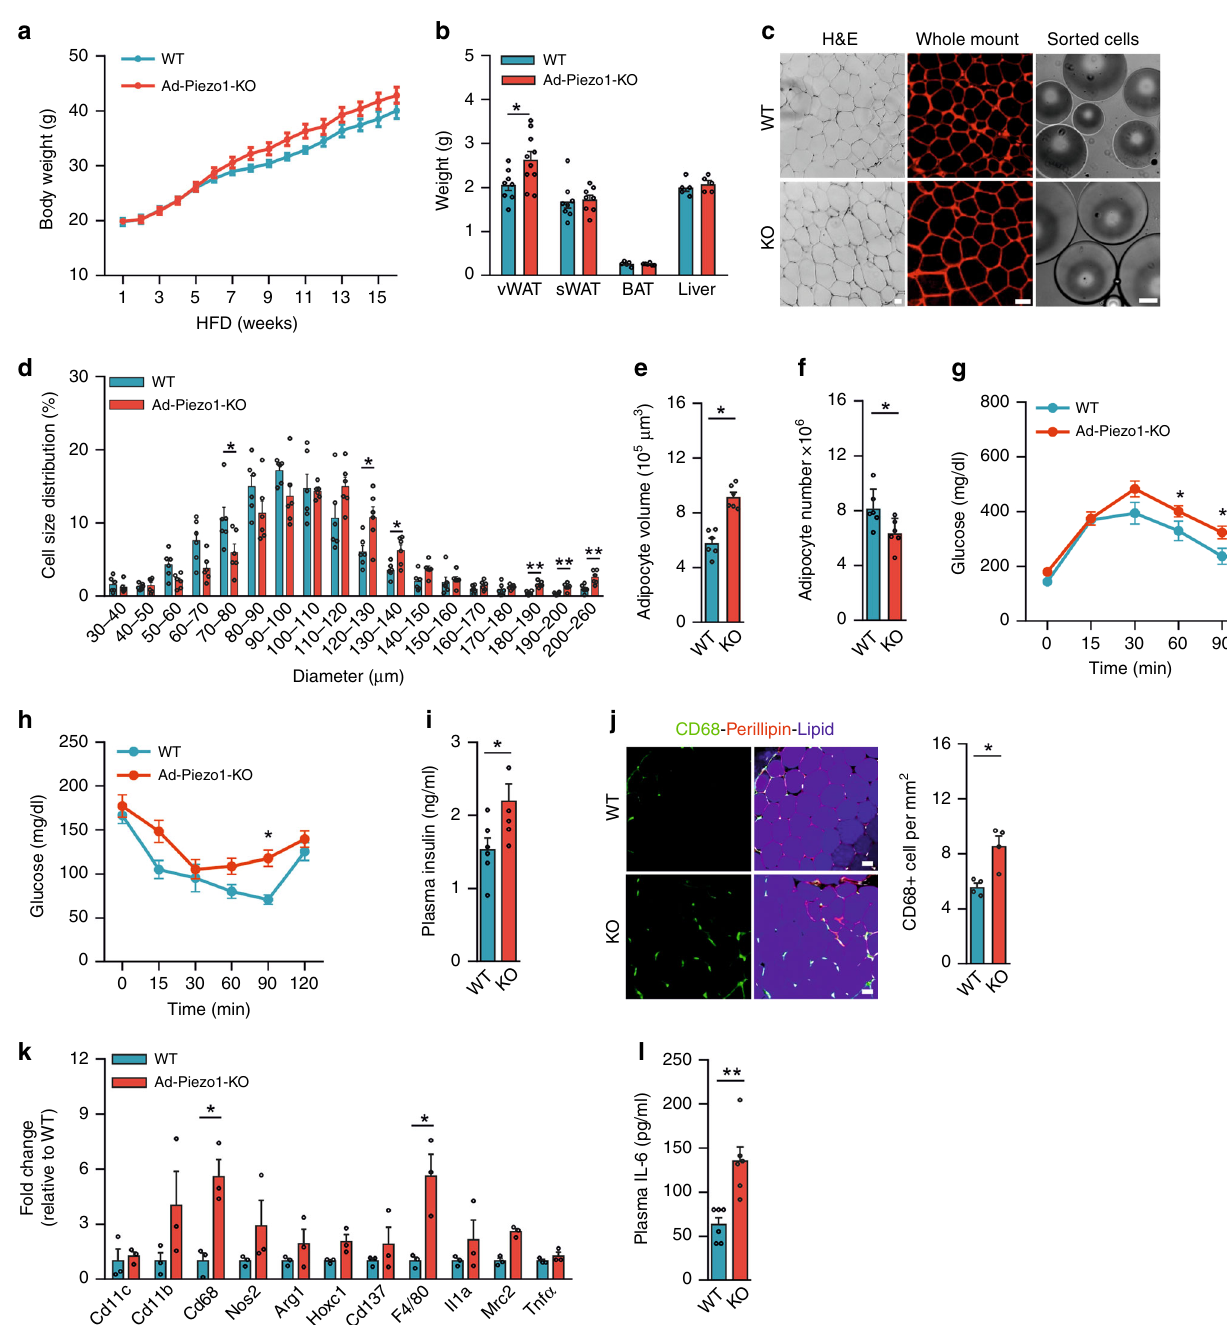
Fig. 2 Metabolic phenotype of Ad-Piezo1-KO mice under HFD. a Body weight of wild-type (WT) or Ad-Piezo1-KO mice during HFD feeding for 16 weeks ( n = 11 mice (WT), n = 12 mice (KO)). b Weight of epididymal vWAT, inguinal sWAT, BAT and the liver from wild-type (WT) or Ad-Piezo1-KO mice fed a HFD for 16 weeks ( n = 8 mice (vWAT WT and sWAT); n = 5 mice (BAT WT and liver); n = 10 mice (vWAT KO); n = 6 mice (BAT KO)). c H&E-stained vWAT sections, whole-mount vWAT stained with anti-perilipin antibodies and sorted vWAT adipocytes from wild-type (WT) and Ad-Piezo1-KO (KO) mice; bar length: 50 μ m. Shown is a representative of 4 independent experiments. d Distribution of size of vWAT adipocytes prepared from wild-type (WT) and Ad-Piezo1-KO mice fed HFD for 16 weeks ( n = 6 mice (WT and KO each)). e , f Average volume ( e ) and total number ( f ) of adipocytes in epididymal vWAT from wild-type (WT) and Ad-Piezo1-KO (KO) mice ( n = 6 mice (WT and KO each)). g – i Glucose tolerance ( g ), insulin tolerance ( h ) and plasma insulin levels ( i ) in wild-type (WT) and Ad-Piezo1-KO mice (KO) fed a HFD for 16 weeks ( n = 6 mice (WT in g , WT and KO in i , h ), n = 7 mice (KO in g )). j Whole mount of vWAT from wild-type (WT) or Ad-Piezo1-KO mice (KO) stained with anti-CD68 and anti-perilipin antibodies as well as with LipidTOX (lipid); bar length: 50 μ m. The bar diagram shows the statistical evaluation of CD68-positive cells per area ( n = 4 mice (at least 10 sections per mouse)). k , l Expression of in fl ammation marker genes in vWAT ( k ) and IL-6 levels in plasma ( l ) from wild-type (WT) and Ad-Piezo1-KO mice (KO) fed HFD for 16 weeks ( n = 3 mice (WT and KO each in k ), n = 6 mice (WT and KO each in l )). Shown are mean values± s.e.m.; * P ≤ 0.05; ** P ≤ 0.01; n.s., not signi fi cant (two-tailed non-parametric Mann – Whitney U -test). Source data are provided as a Source data fi